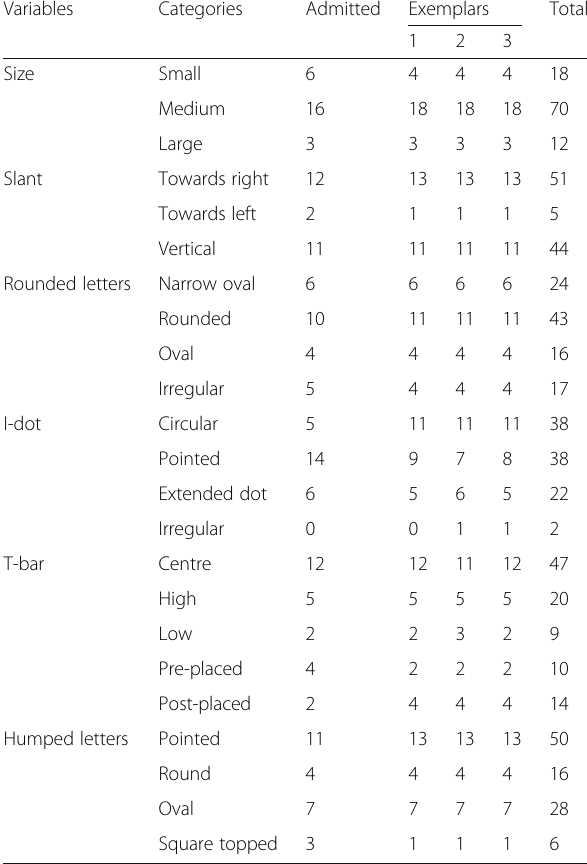
Table 2 Cross-tabulation of the size, slant, rounded letters, i-dot, t-bar, and humped letters with admitted and exemplars